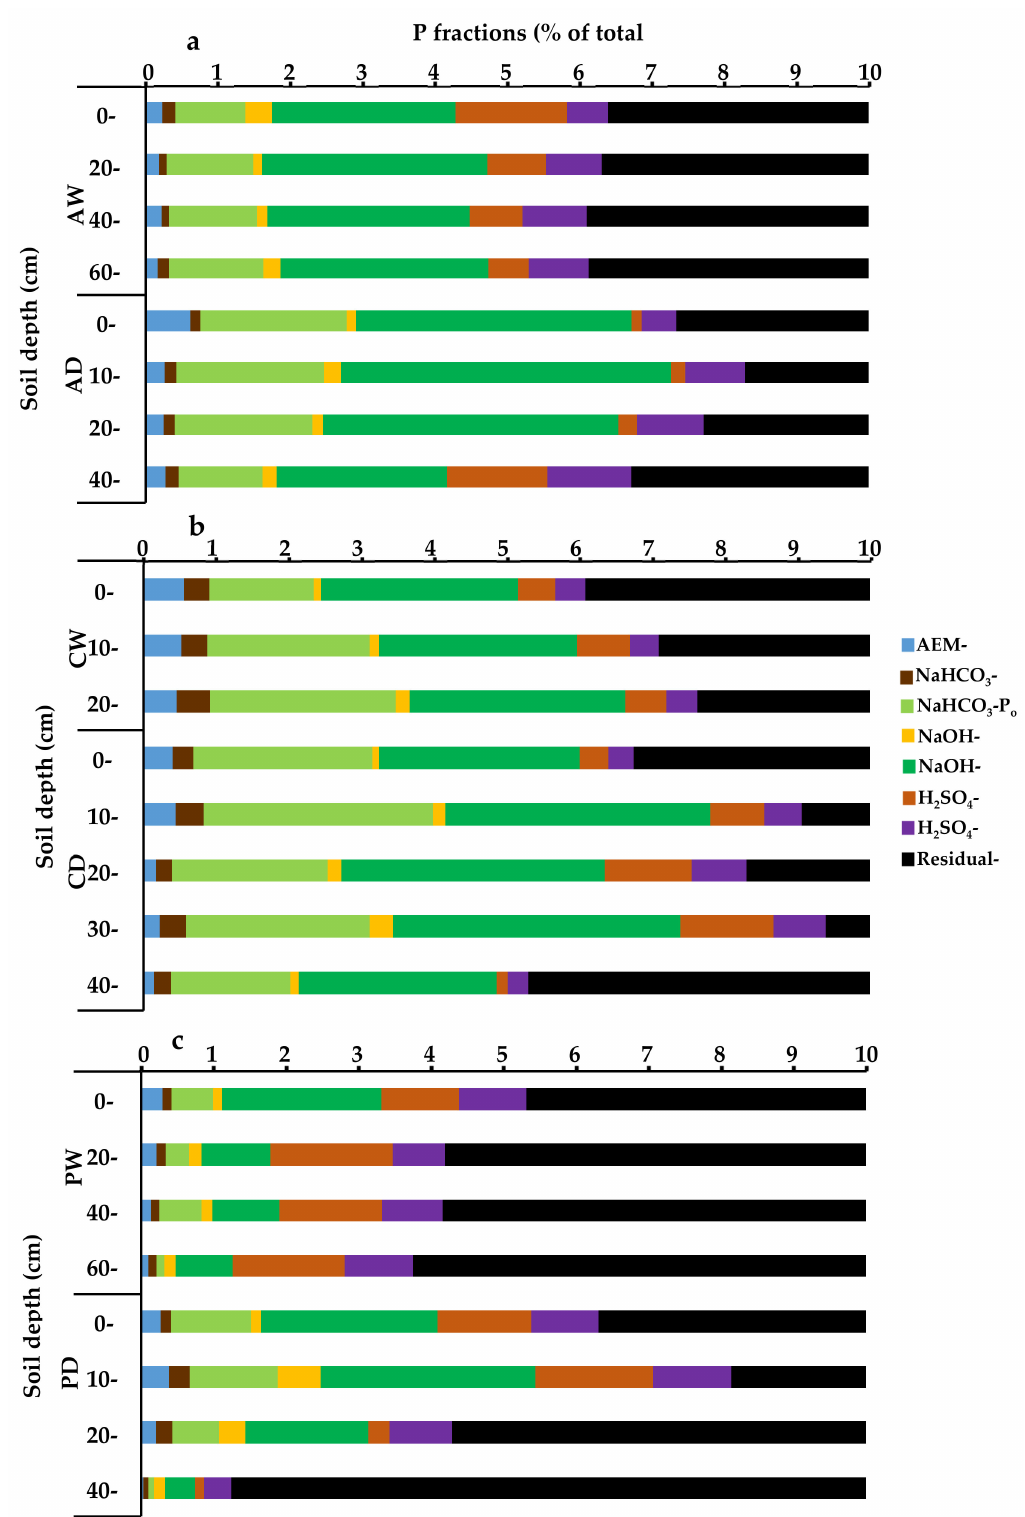
Figure 2. Relative proportions of di ff erent P fractions in the drained and rewetted peatlands. ( a ): drained and rewetted forest peatlands, ( b ): drained and rewetted coastal peatlands, ( c ): drained and rewetted peatlands. AEM-P: extracted by anion exchangeable membrane, NaHCO 3 -P i and NaHCO 3- P o : labile inorganic and organic P, NaOH-P i and NaOH-P o: moderately labile organic and inorganic p, H 2 SO 4 -P and Residual-P: Stable inorganic and organic P